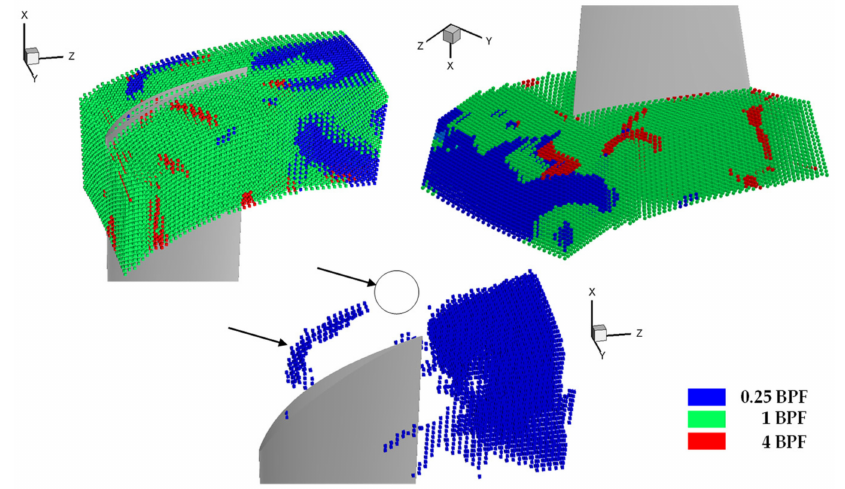
Figure 20. Dominant frequency analysis of close_C.